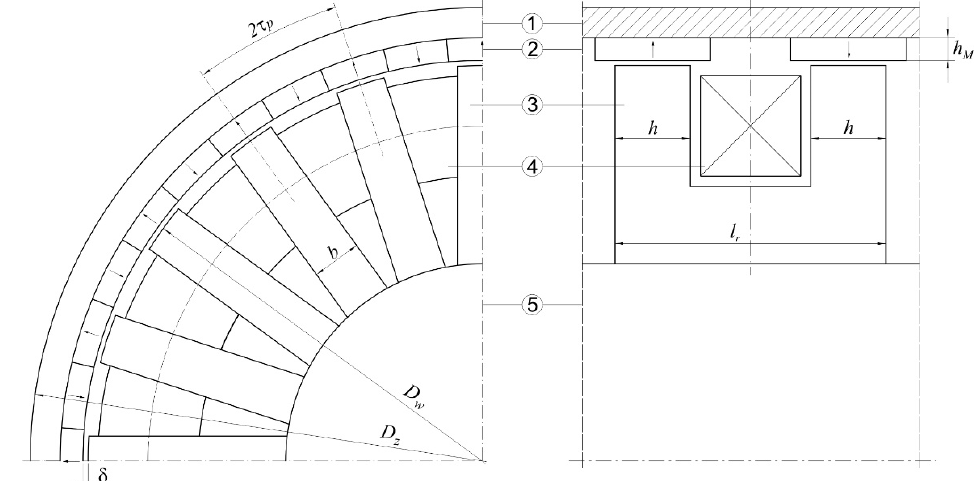
Figure 1. Cross ‐ section and longitudinal section of the transverse flux machine (TFM) basic version: 1—outer steel cylinder, 2—permanent magnets, 3—armature components—U cores, 4—winding ring, 5—hub/shaft.